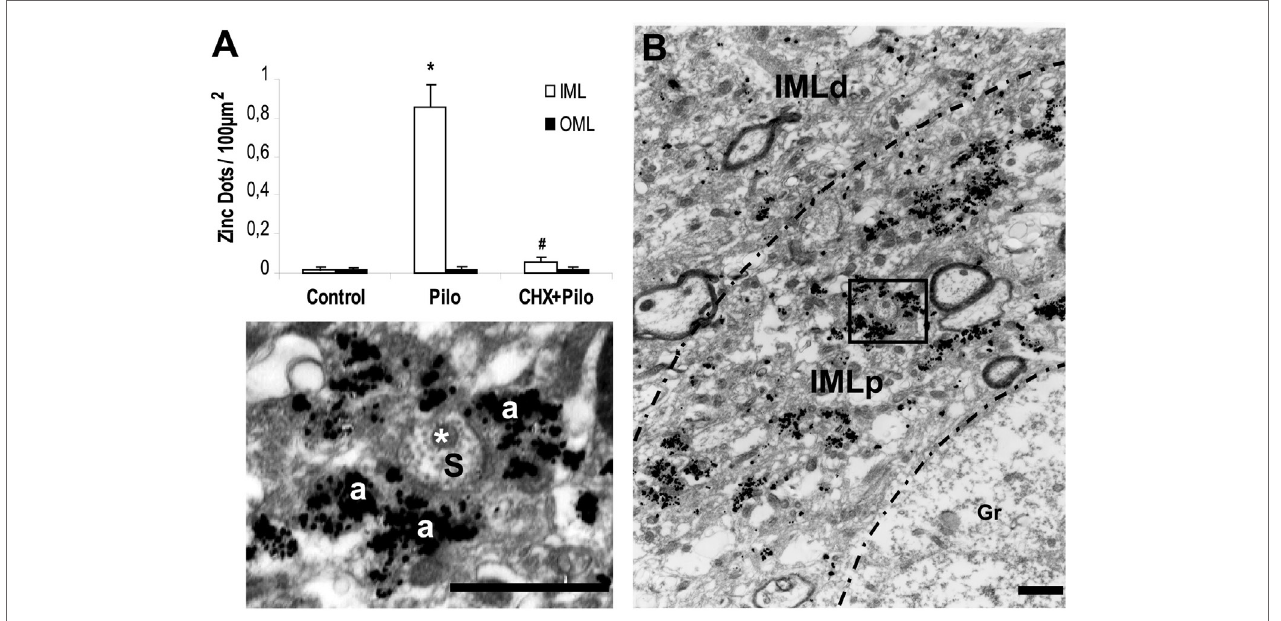
FigUre 3 | (a) Density of silver grains staining per 100 μ m 2 within dentate molecular layer of control, pilocarpine (Pilo)- and cycloheximide + pilocarpine (CHX + Pilo)-treated animals. IML, inner molecular layer; OML, outer molecular layer. * P < 0.001; compared to controls; # P < 0.001; compared to the Pilo group. (B) Sections at the level of the inner molecular layer staining for mossy fiber sprouting of Pilo-treated animal. Note the greater silver grains staining in the molecular layer more proximal (IMLp) to the granule cell layer (Gr) as compared to the more distal portion of the inner molecular layer (IMLd). In these higher magnification views, histochemically reactive silver grains could easily be localized on the asymmetric synapse contacts. Axon terminal (a) and dendritic shaft (s) with mitochondria (*). IMLp, Inner molecular layer proximal; IMLd, inner molecular layer distal. Scale bars, 1.25 μ